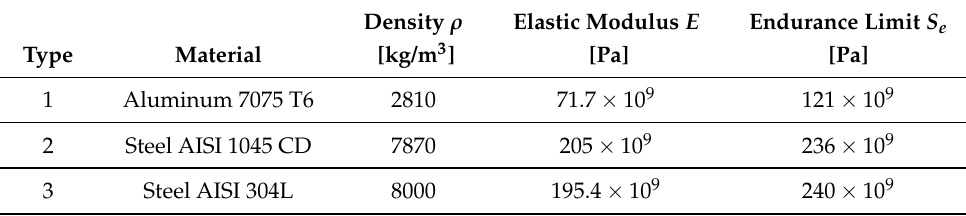
Table 1. Physical properties of the selected materials.